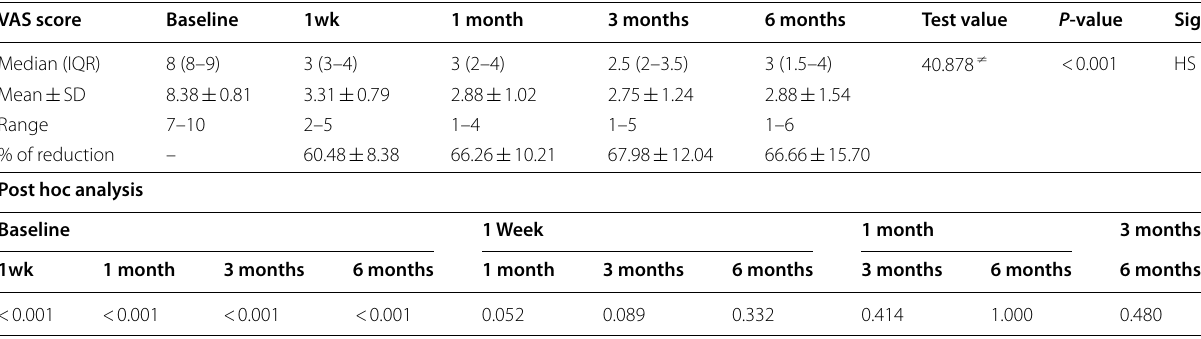
Table 1 Comparison between the baseline VAS score and its follow-up at 1 week, 1, 3 and 6 months after embolization